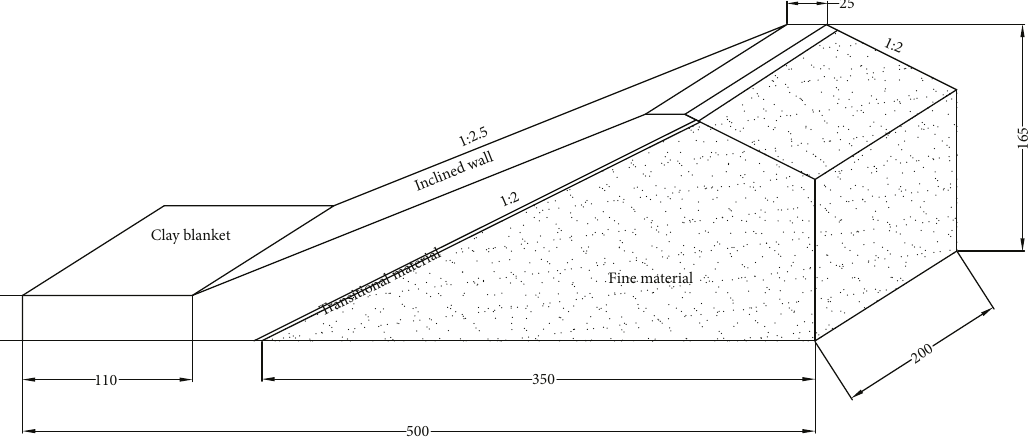
Figure 3: Test model (unit: cm).